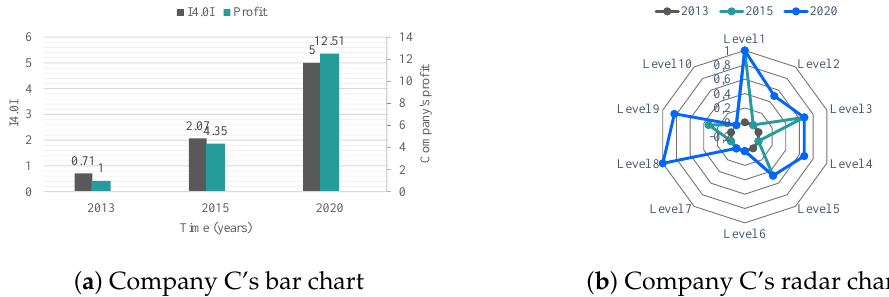
Figure 7. Company C’s graphics generated by the answers obtained by the questionnaire